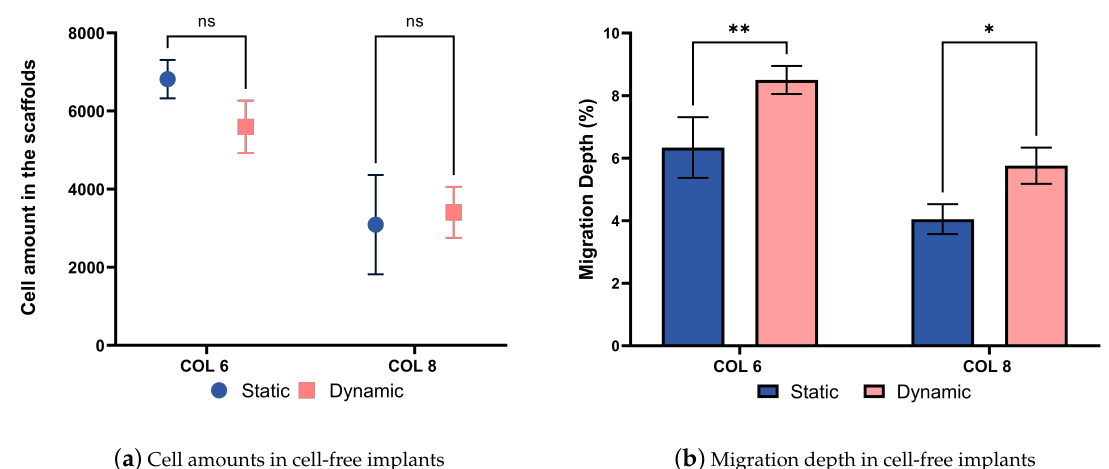
Figure 12. ( a ). Alive cell amounts migrated from the cell-seeded collagen construct to the COL-6 and COL-8 implants. ( b ). The migration depth in percentages between the static and dynamic culture of COL-6 and COL-8 implants. statistically difference.*: p ≤ 0.05; **: p ≤ 0.01